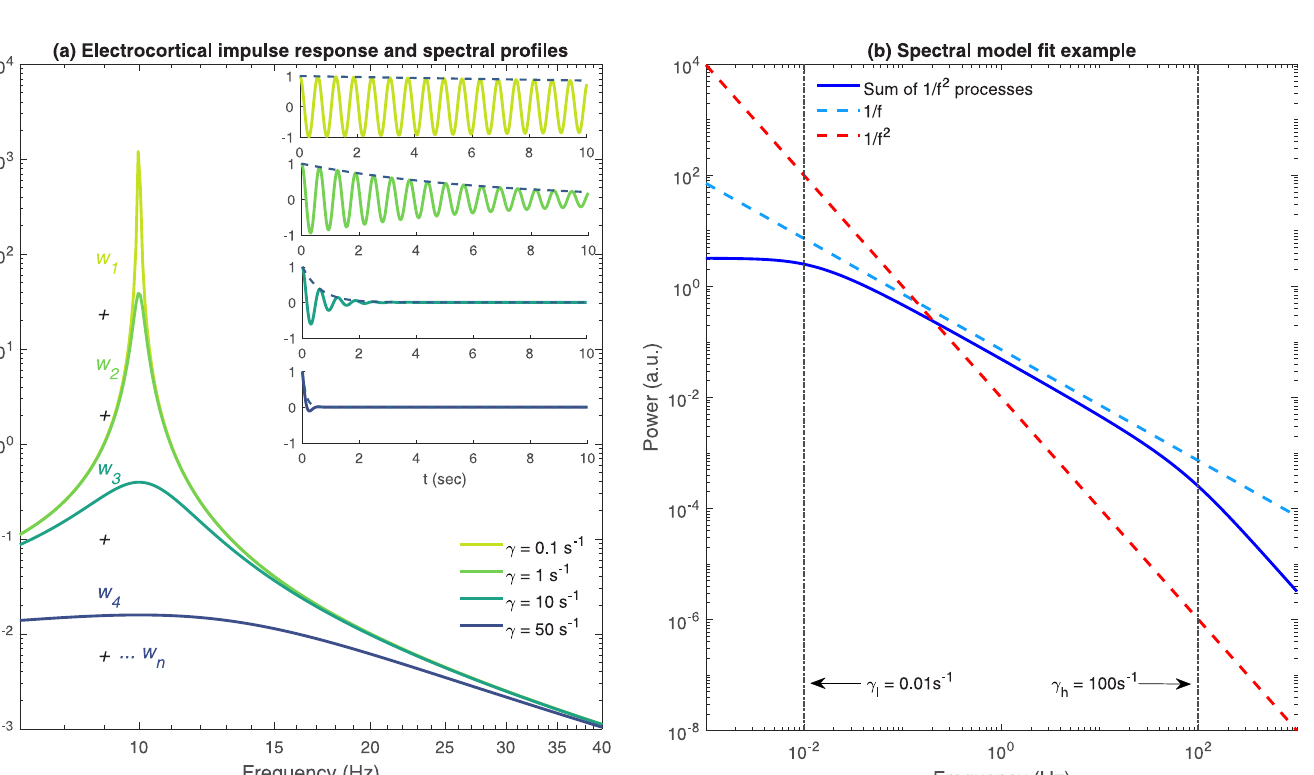
PLOS Computational Biology | https://doi.org/10.1371/journal.pcbi.1010012 April 15,